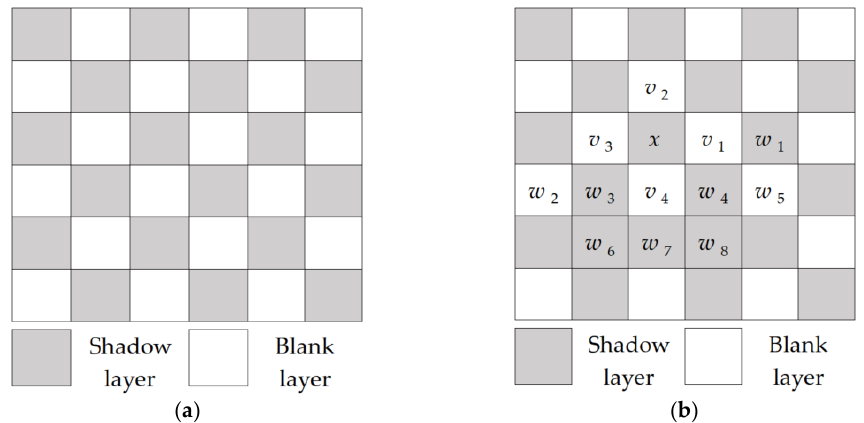
Figure 1. The scheme of double-layer division and the local neighborhood: ( a ) Double-layer Di- vision; ( b ) The local neighborhood, where x is the current pixel, v k , 1 ≤ k ≤ 4 composes the four-neighborhood, both v k and w j , 1 ≤ j ≤ 4 forms the local